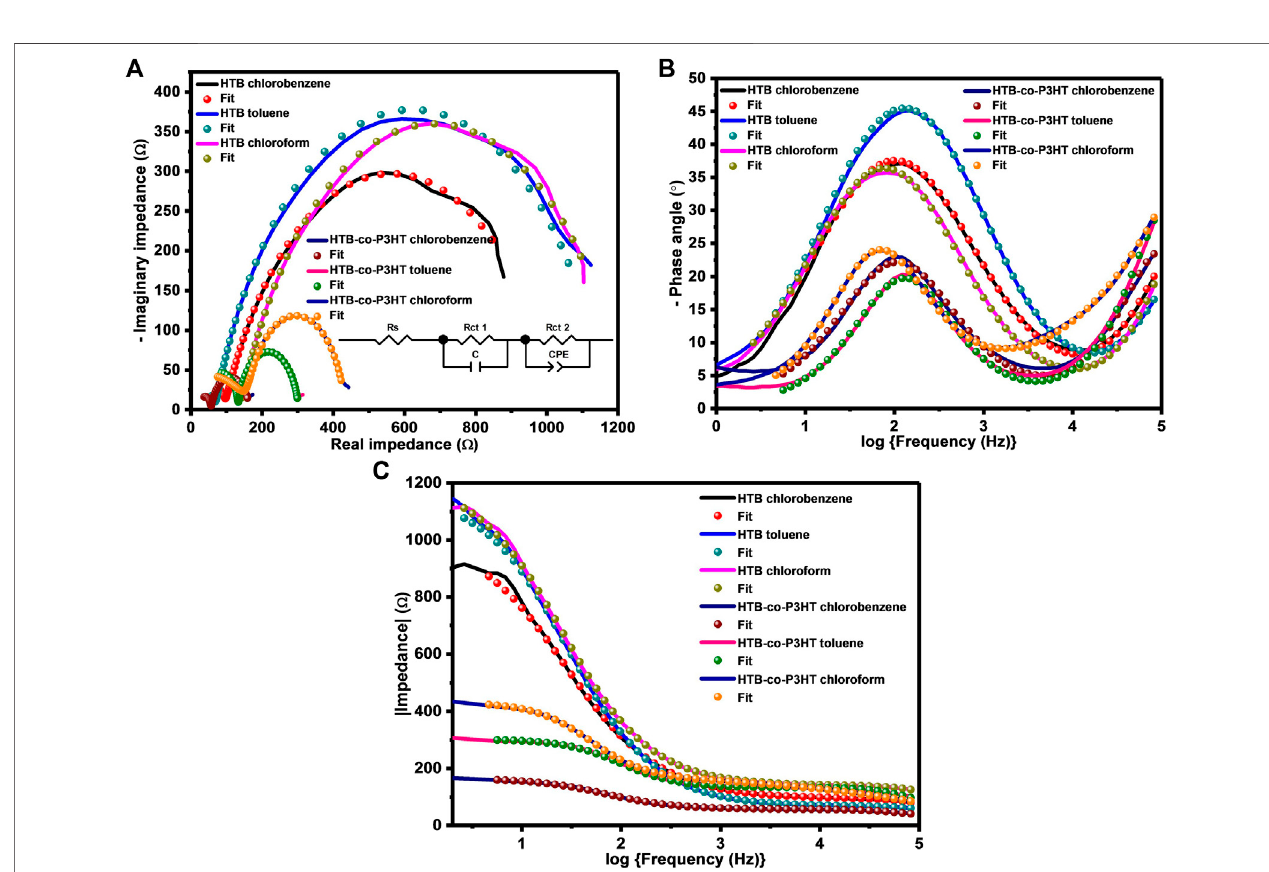
FIGURE 10 | (A) Nyquist plots, (B) Bode phase angle plots and (C) Bode impedance plots of HTB and HTB-co-P3HT prepared in different solvents.